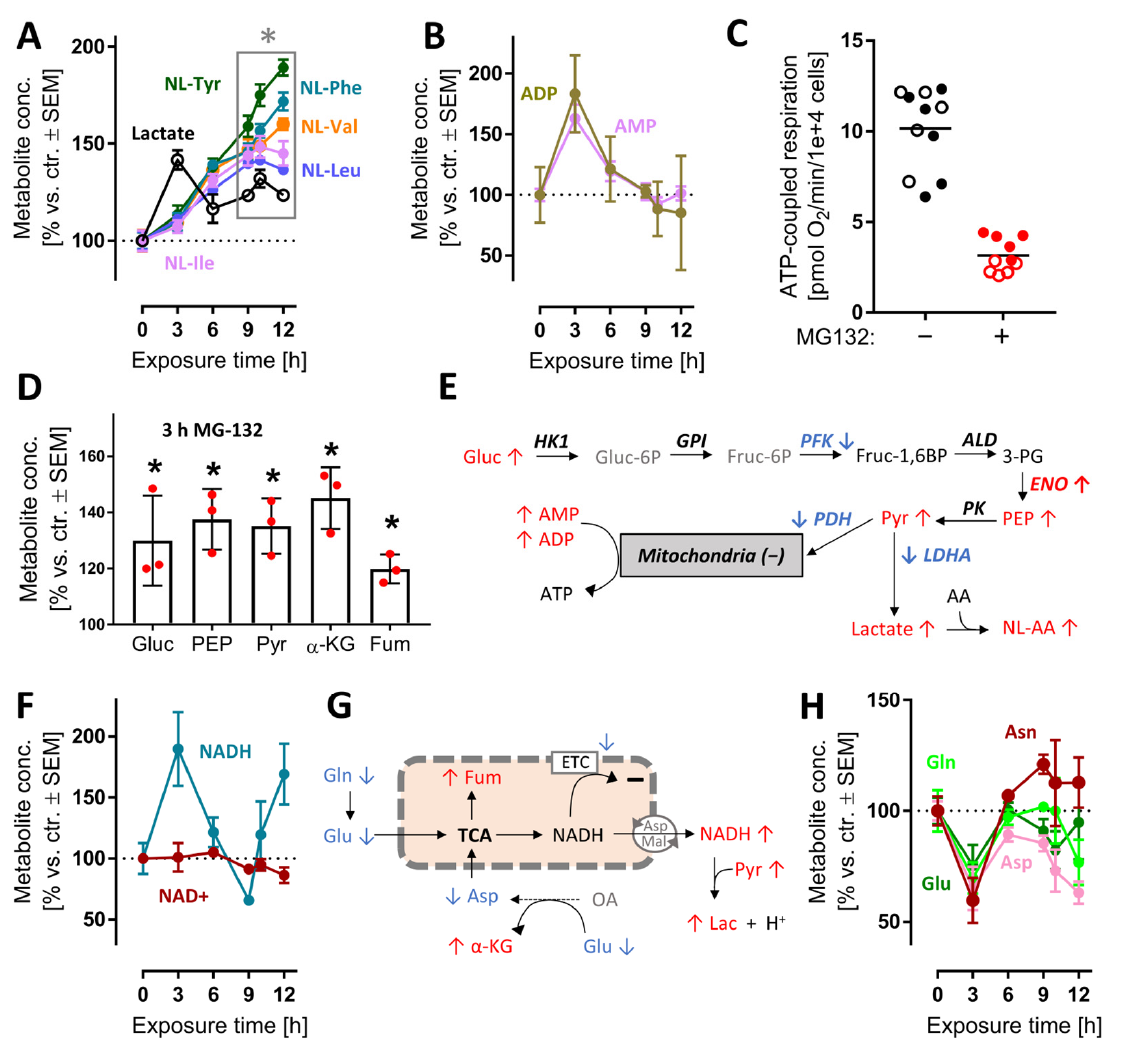
Figure 5. Early perturbation of neuronal energy metabolism after MG-132 treatment. Metabolome and transcriptome samples were obtained as detailed in Figure 1. Data on relative levels of metabo- lites were extracted from the metabolome data matrix (Figure 1 and Figure S4). ( A , B ) Time-dependent changes of lactate, N-lactoyl amino acids (NL-AA), ADP and AMP. ( C ) Data on ATP-coupled respira- tion were obtained as derivative measure of the overall oxygen consumption rate at 6 h after MG treatment. Filled and empty circles belong to 2 completely separate experiments, each with at least 5 independent replicates. ( D ) Changes of metabolites related to mitochondrial function after 3 h MG. Independent replicates are represented as dots. ( E ) Scheme of glycolysis with mapped measurements for metabolites (3 h) and transcripts (9 h). Up-regulations are shown in red, down-regulations in blue and unchanged levels in black. ( F ) Time-dependent changes of nicotinamides. ( G ) Scheme of mitochondrial metabolism with mapped measurements for metabolites (3 h). ( H ) Time-dependent changes of energy-related amino acids. A complete set of data for the pathways in ( E ) is provided in Figure S12. A full overview of captured metabolites is found in Table S1. A full overview of targeted transcripts is provided in Table S2. Data are means ± SEM of independent replicates. For MG-132 treatments, 3 different samples were analyzed. For controls, 4 replicates were prepared to provide for more robust baseline data. * adjusted- p < 0.05; α -KG, α -ketoglutarate; ADP, adenosine diphosphate; AMP, adenosine monophosphate; Fum, fumarate; LDH, lactate dehydrogenase; NAD+, oxidized nicotinamide adenine dinucleotide; NADH, reduced nicotinamide adenine dinucleotide; PDH, pyruvate dehydrogenase; PEP,